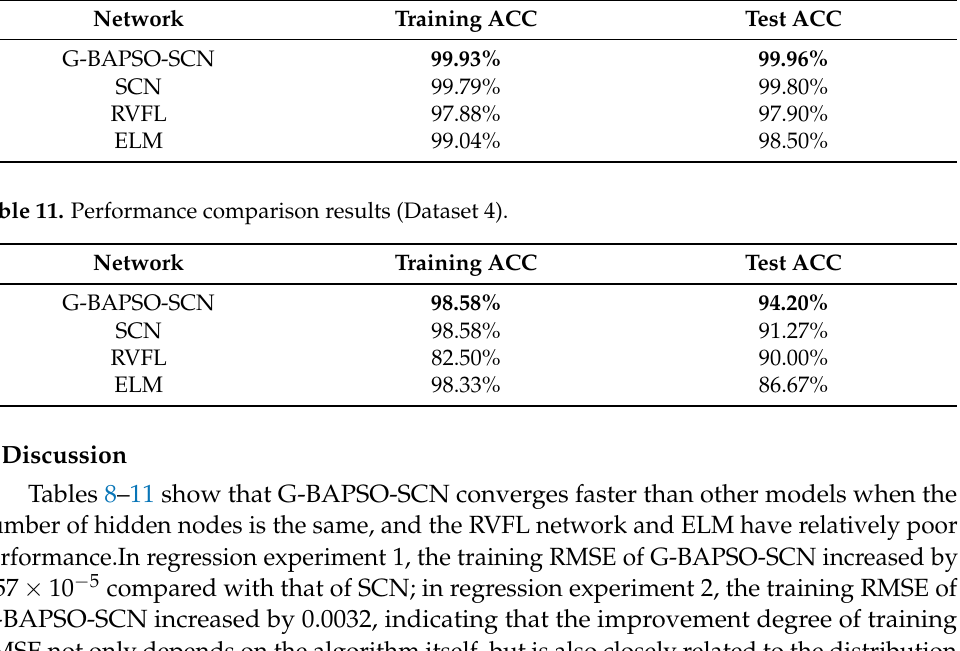
Table 10. Performance comparison results (Dataset 3).